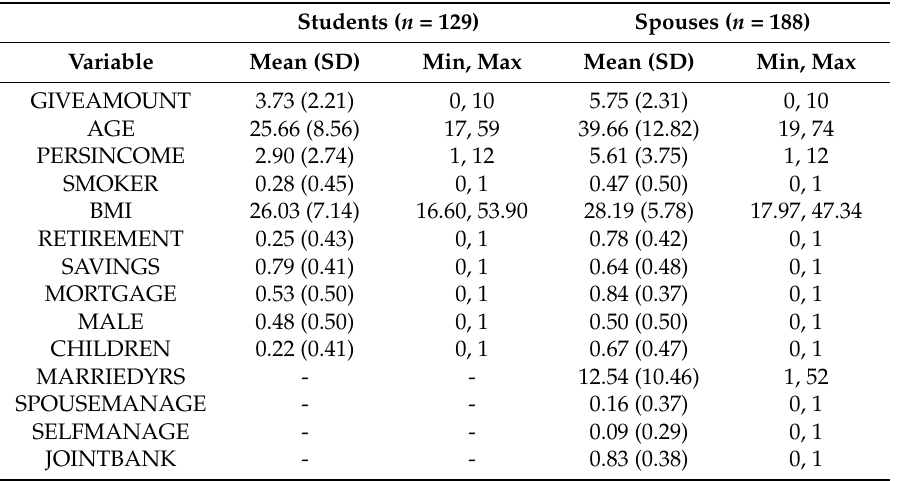
Table 2. Basic statistics for students and